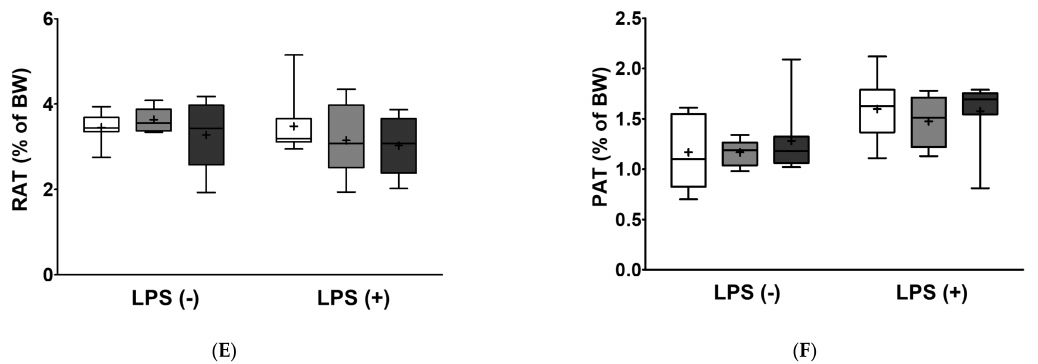
Figure 3. Partial replacement of dietary fat with PO or CO and LPS challenge on the liver and adipose tissue weights in ob/ob mice. Mice were fed either an ND or an ND partially replaced with PO or CO for 12 weeks and then treated with PBS or LPS (1 mg/kg) for 24 h ( n = 8 per group). ( A ) Liver weight; ( B ) white adipose tissue (WAT) weight; ( C ) epididymal adipose tissue (EAT) weight; ( D ) mesenteric adipose tissue (MAT) weight; ( E ) retroperitoneal adipose tissue (RAT) weight; ( F ) perirenal adipose tissue (PAT) weight. Values are presented as box and whisker plots representing 8 mice per group. Data were analyzed using two-way ANOVA followed by Tukey’s post hoc test (LPS × Diet interaction). LPS, lipopolysaccharide; PBS, phosphate-buffered saline. 2.6. PO or CO Attenuates Cardiovascular Risk Markers in LPS-Injected ob/ob